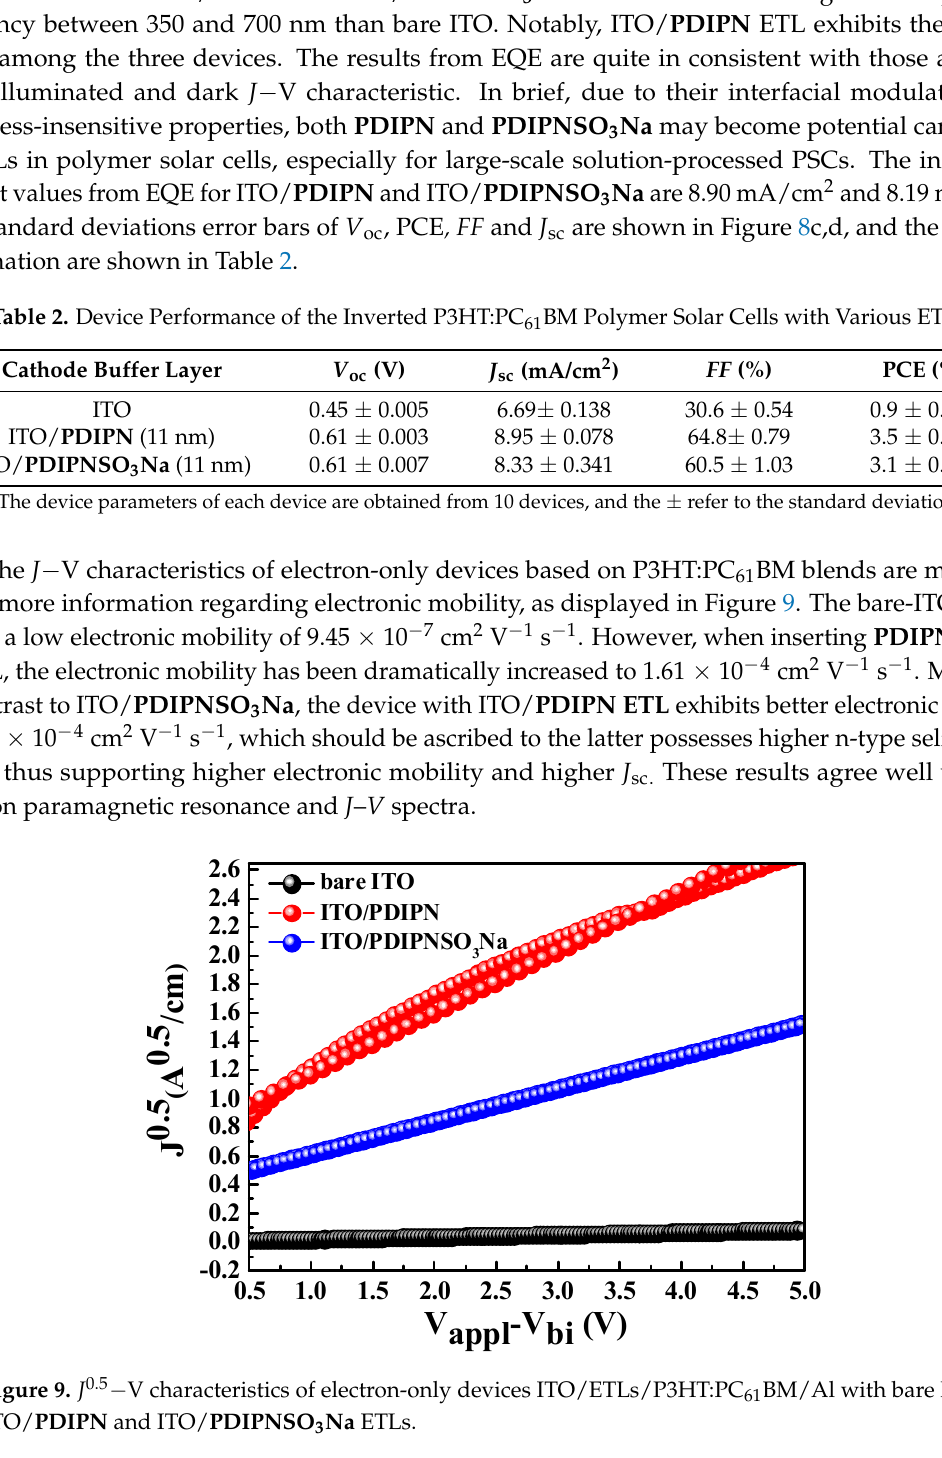
Table 2. Device Performance of the Inverted P3HT:PC 61 BM Polymer Solar Cells with Various ETLs. Cathode buffer layer